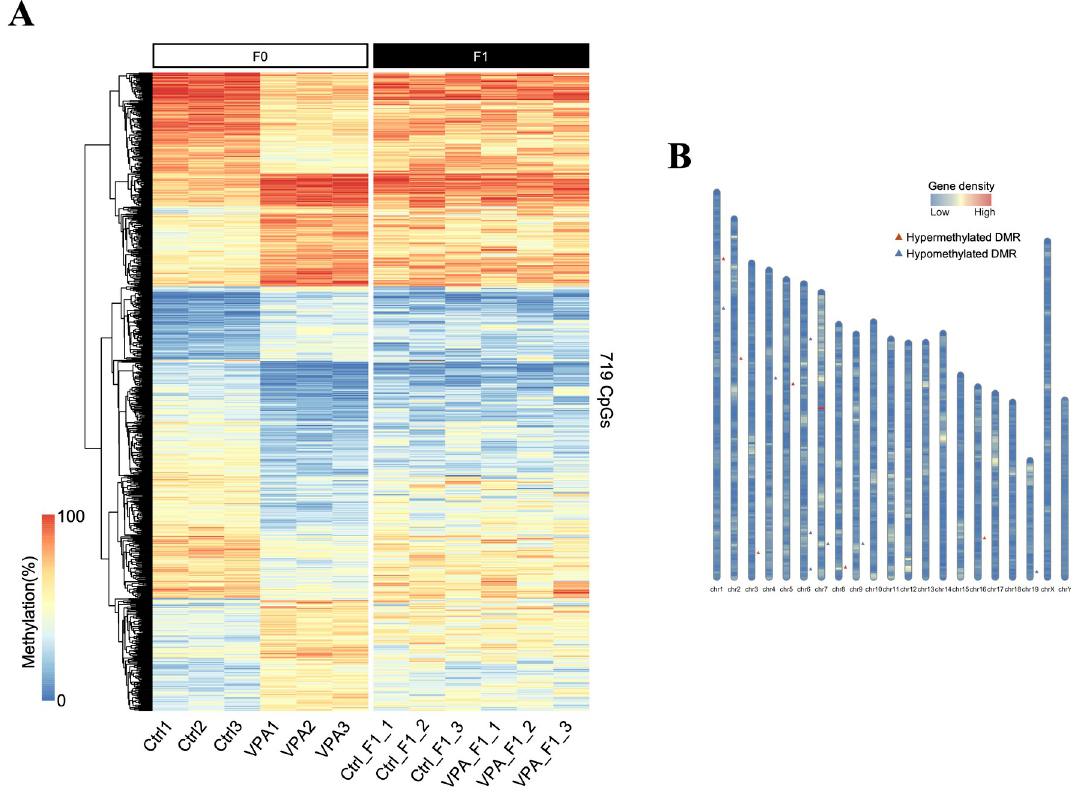
Fig 6. Sperm DNA methylation analysis of VPA-treated F1 mice using whole-genome bisulfite sequencing. (A) Heat map comparison of all samples of sperm DNA methylation levels, including data from the next generation of VPA-treated mice (VPA_F1) and next generation of control group mice (Ctrl_F1) at promoter CpG loci where significant changes were observed in the VPA- treated generation (F0 generation, shown in Fig 2A). The left six columns indicate the F0 generation and right six columns the F1 generation. (B) Positions of differentially methylated regions found in the VPA_F1 group compared with those of the Ctrl_F1 group are indicated by markers on the ideogram.